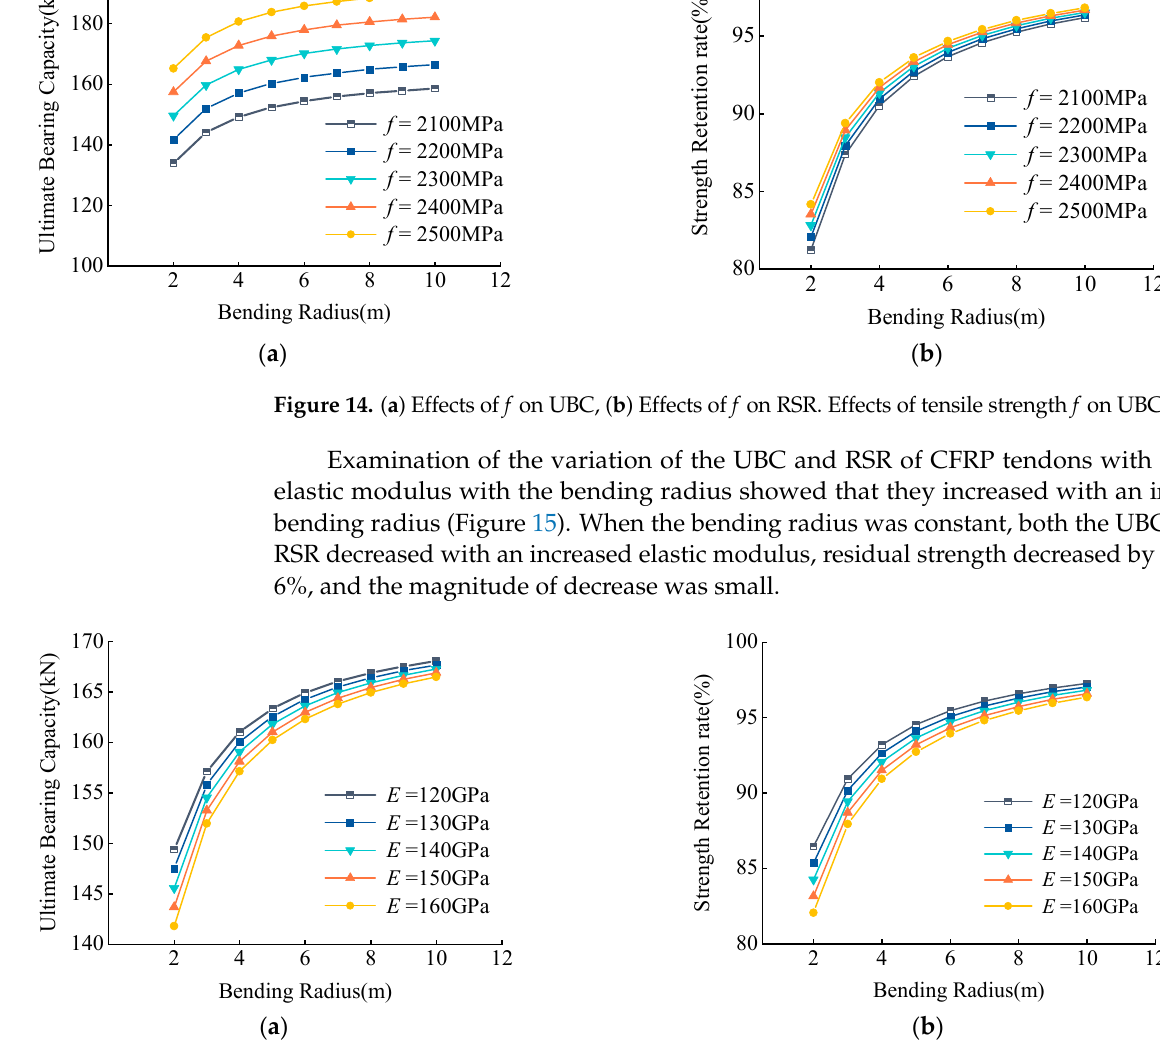
increased with increased tendon strength f, the residual strength increased by <4%, and the magnitude of increase was small. Figure 13. ( a ) Effects of r on UBC, ( b ) Effects of r on RSR. Effects of radius of carbon fiber tendons r on UBC and RSR. Examination of the variation of the UBC and RSR of CFRP tendons with different strengths with bending radius showed that they increased with an increased bending radius (Figure 14). When the bending radius was constant, both the UBC and RSR